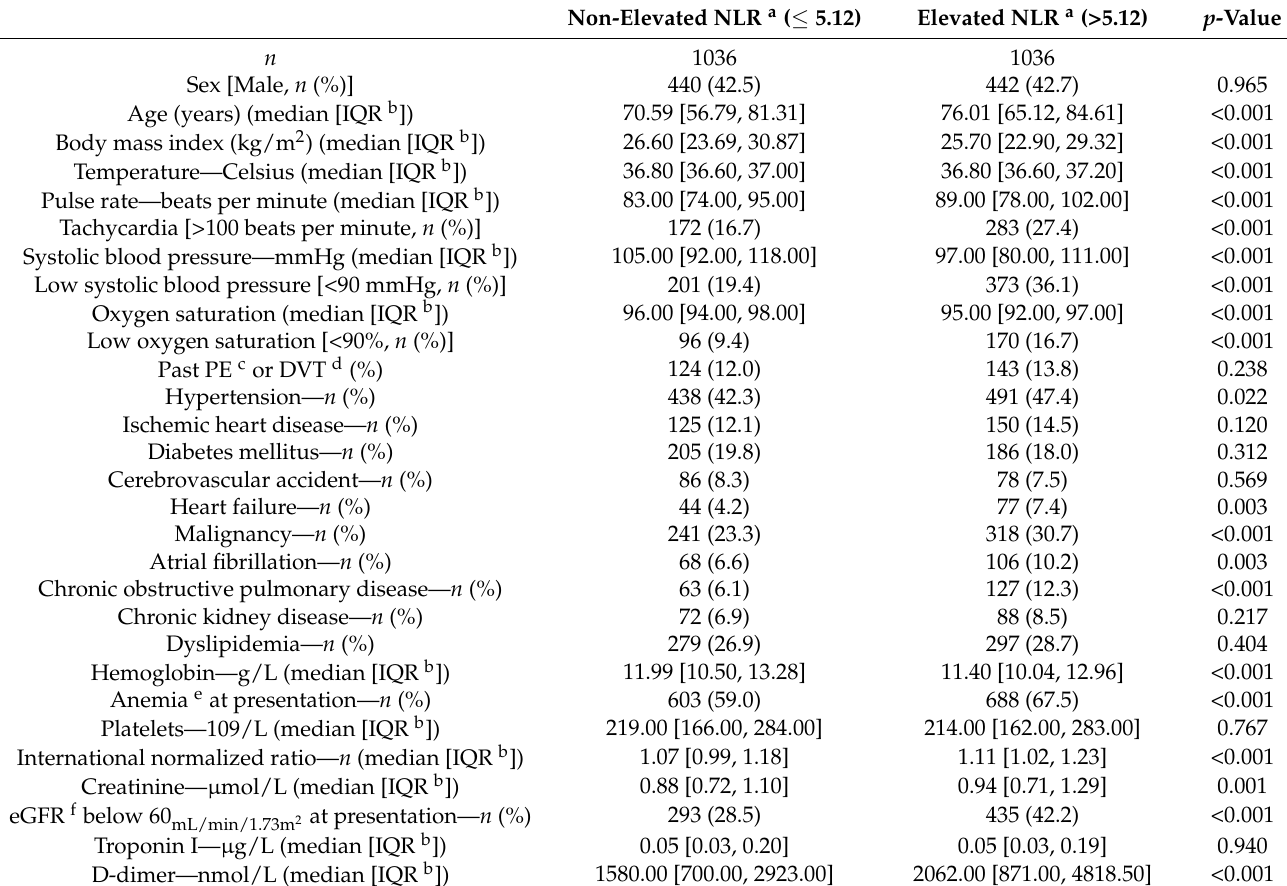
Table 1. Characteristics of patients at